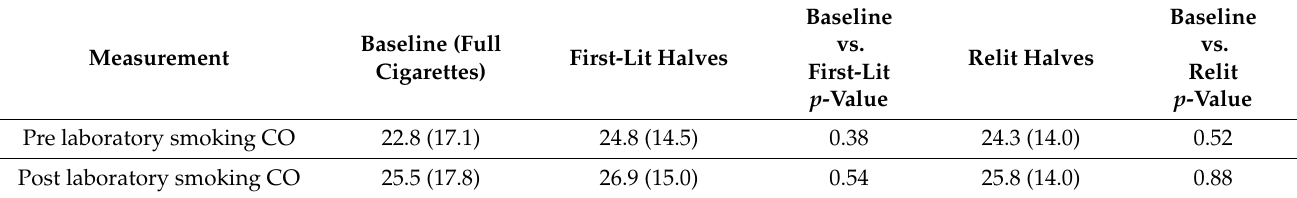
First-Lit Halves